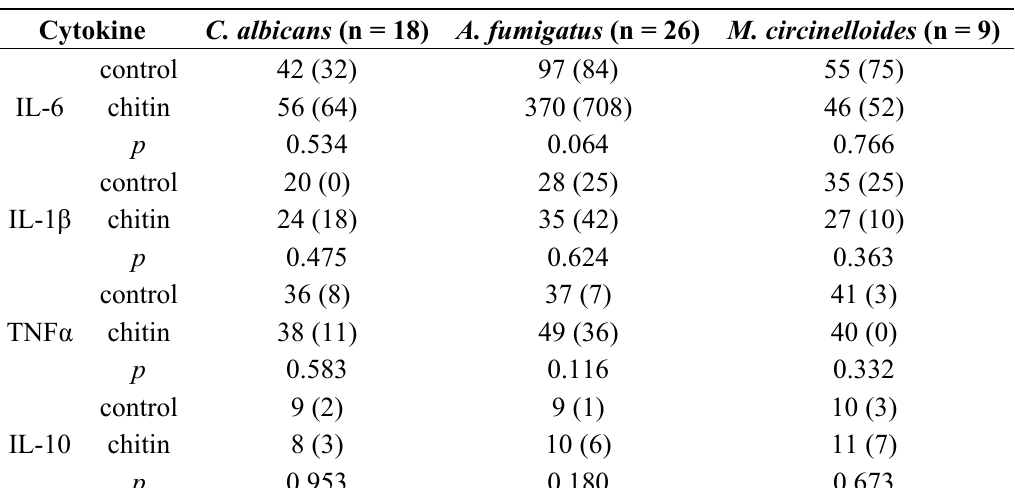
Table 3. Cytokines produced after exposure of hyphal SSCs to hPBMCs. SSCs were purified from three different filamentous fungi as